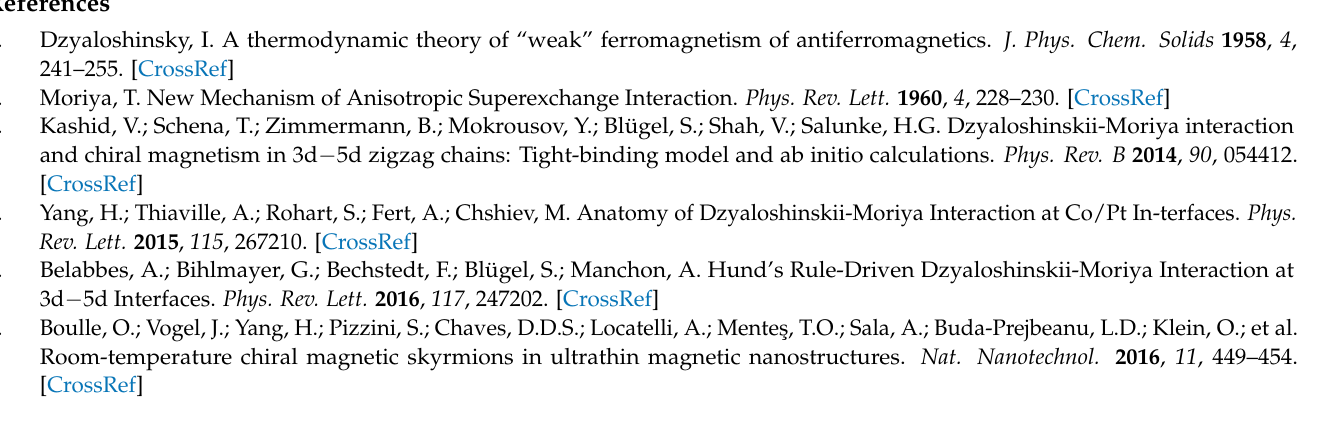
Supplementary Materials: The video animations of the eigenmodes for the stripes and the dots